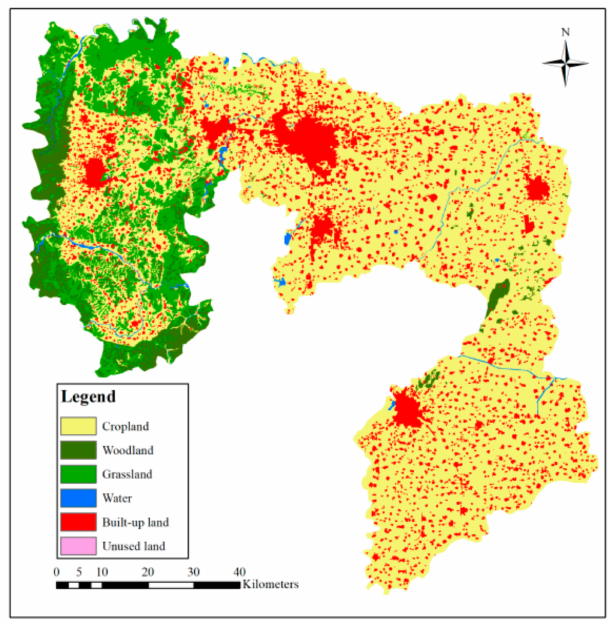
Figure 8. The land use coverage map of Anyang